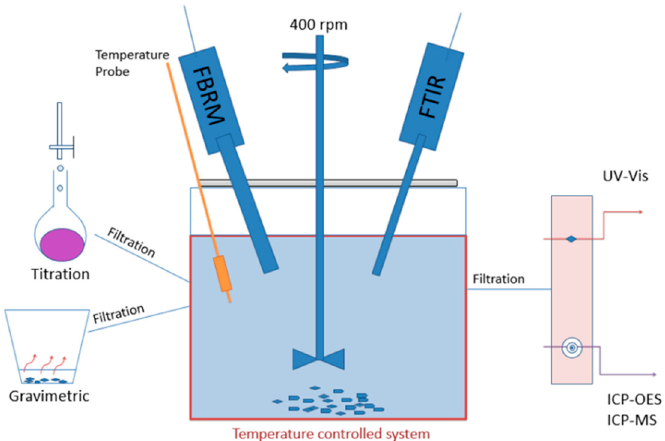
Figure 1. Schematic illustration of isothermal solubility experiments. A suspension of excess Calcium Oxalate Monohydrate (COM) crystals in ultrapure water or a bu ff er solution was brought in equilibrium at designated temperature and pH values. The suspension is filtered to isolate the saturated solution from crystals at fixed temperature. The saturated solution is diluted at the same temperature to avoid crystallization. The calcium and oxalate ion concentrations in filtered saturated solution are analyzed with the following methods, commonly used for measuring solubility of highly insoluble compounds in literature (from the left to right); gravimetric, titration, Focused Beam Reflectance Measurement (FBRM), FTIR, UV-Vis, Inductively Coupled Plasma Optical Emission Spectroscopy (ICP-OES), and Inductively Coupled Plasma Mass Spectroscopy (ICP-MS). The pseudopolymorphic / hydrate form of the excess solute is quantified prior to and at the end of experiments via in-situ and ex-situ methods.